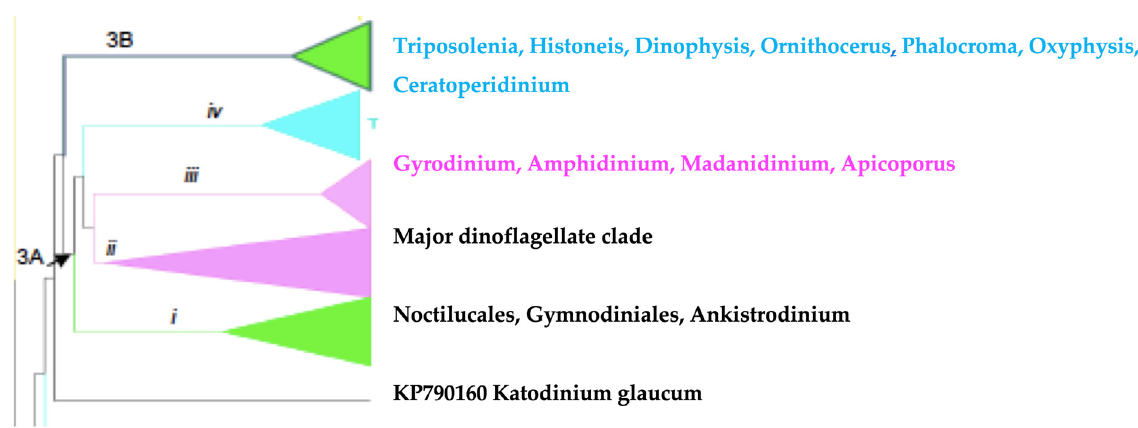
Figure 8. Enlarged view of the two major clades 3A i, ii, iii, iv and 3B .